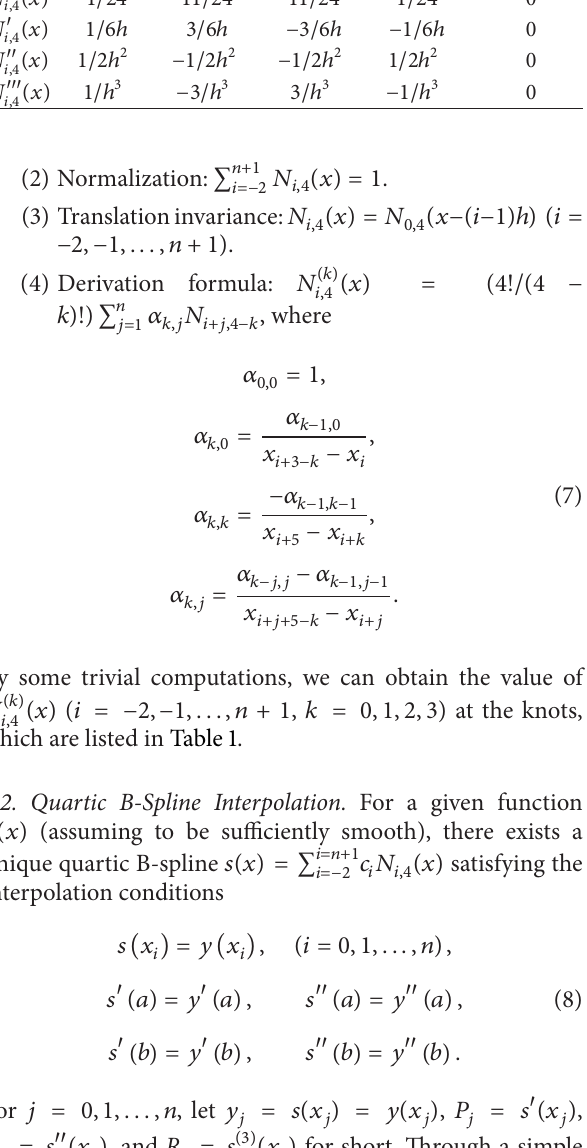
Table 1: The values of 𝑁 (𝑘) 𝑖,4 (𝑥) at the knots. 𝑥 𝑖−1